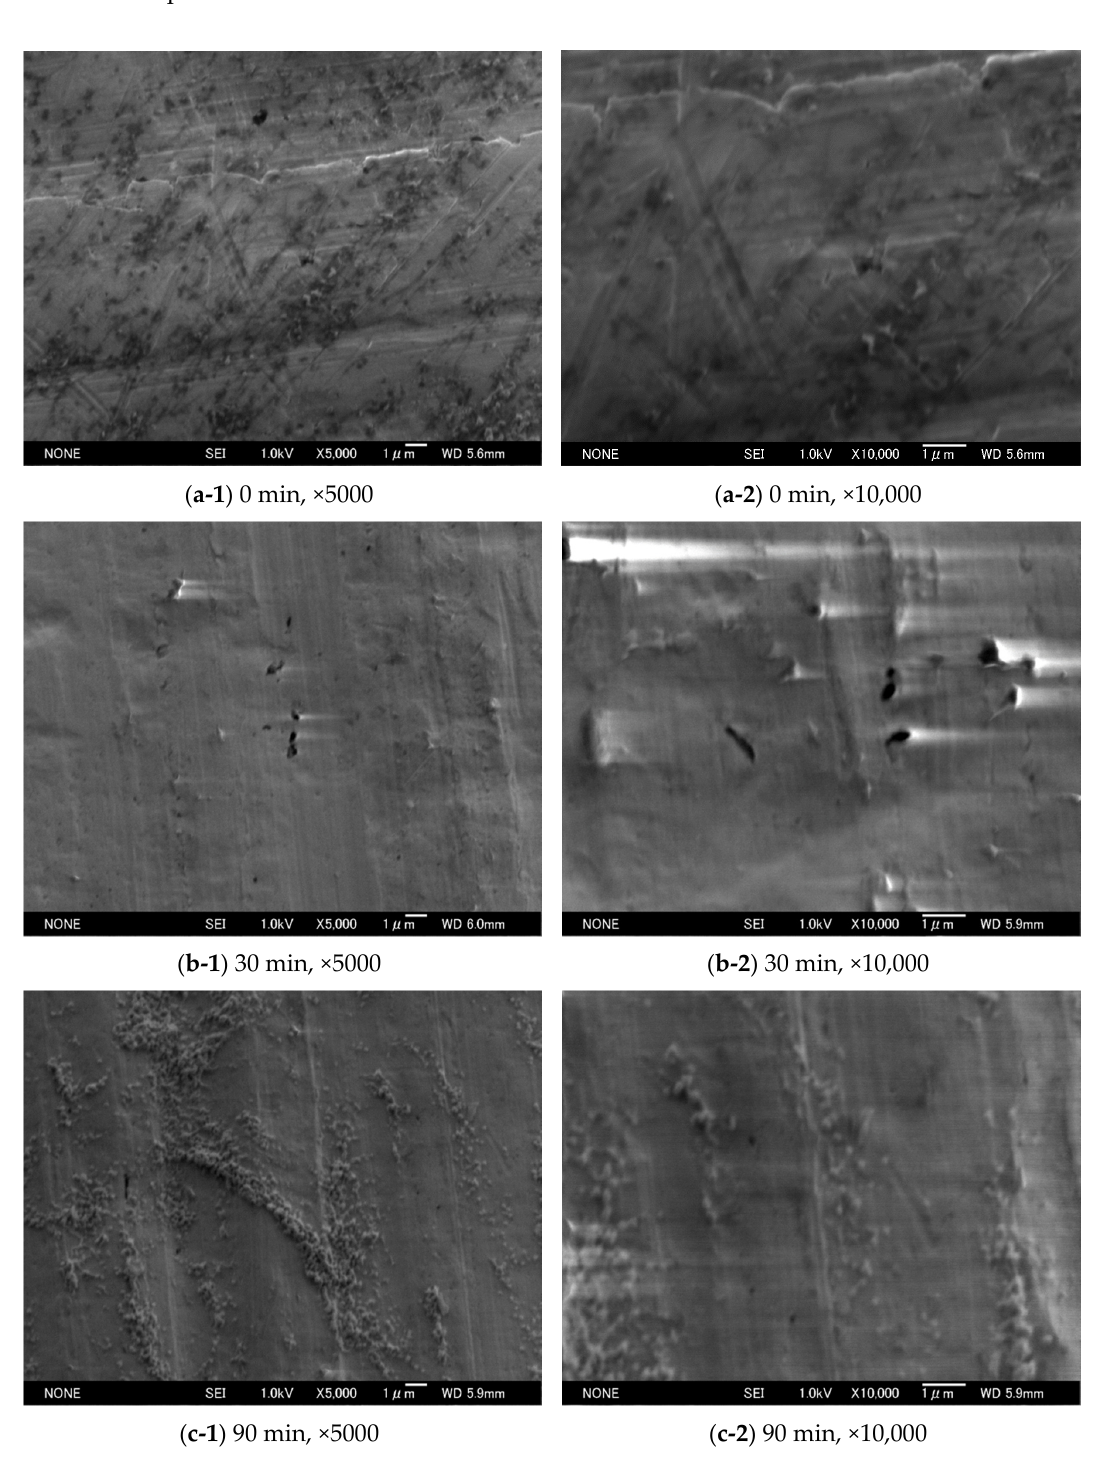
Figure 1. Scanning electron microscope (SEM) images of the anodic oxide films on the sample surfaces: ( a ) 0 min; ( b ) 30 min; and ( c ) 90 min with the magnification of ( 1 ) ×5000; and ( 2 ) ×10,000.